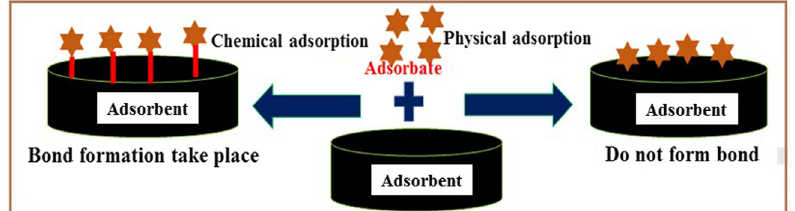
Figure 1: Chemical and physical adsorption